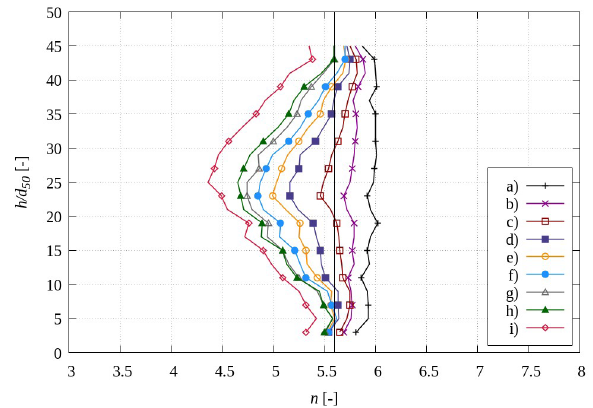
Figure 23: Distribution of coordination number n across the normalized specimen height h / d = 0.25 mm, b) u = 1.25 mm, f) u u = 10.00 mm ( e x line demonstrates 5%